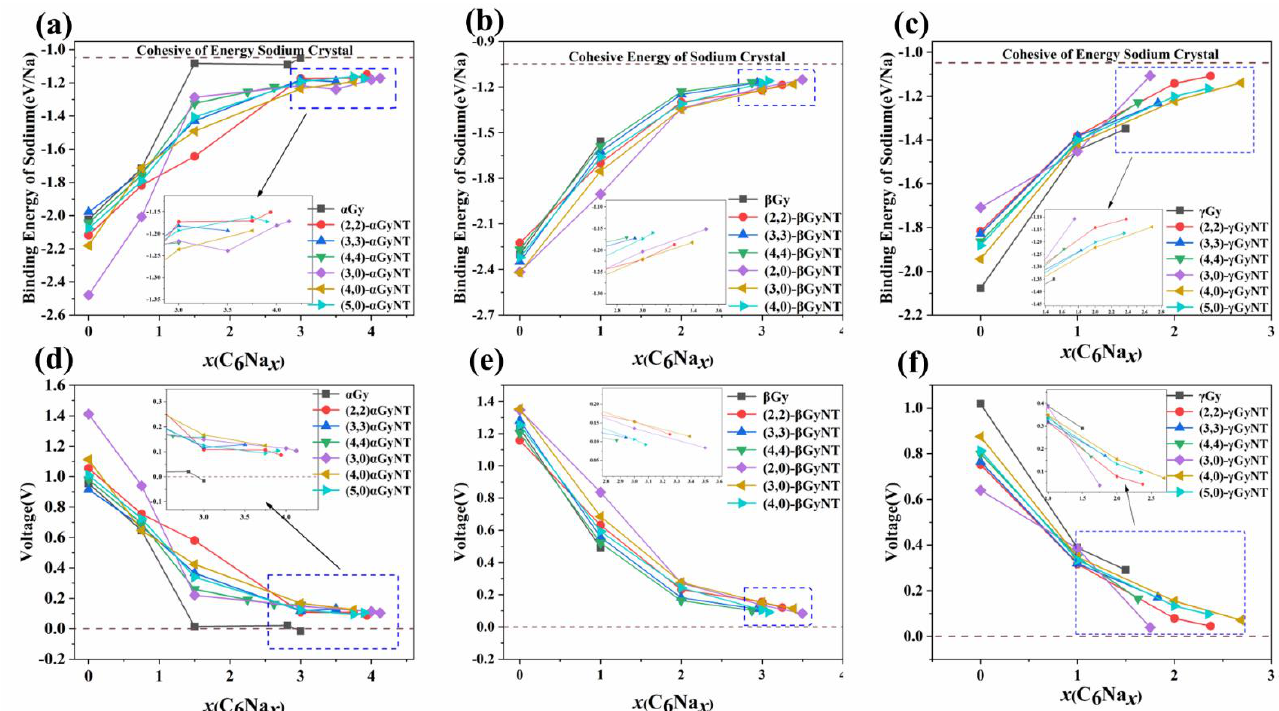
Figure 4. The changes to E b of ( a ) α , ( b ) β , and ( c ) γ GyNTs as a function of the Na concentration x , and V OCV as a function of Na concentration x of ( d ) α , ( e ) β , and ( f ) γ GyNTs. When the 2D Gy is curled seamlessly into a GyNT, the 𝐶 𝑚𝑎𝑥𝑁𝑎 changes significantly, as revealed in prior work. The changes to E b and V OCV as a function of the Na concentration x of α GyNTs are shown in Figure 4a,d. For ( n , n )- α GyNTs, the C Na values were computed to max be C 6 Na 3.94 , C 6 Na 3.50 , and C 6 Na 3.00 when n = 2, 3, and 4, respectively, and the correspond- ing E b and V OCV values are − 1.15, − 1.19, and − 1.22 eV/Na and 0.12, 0.11, and 0.10